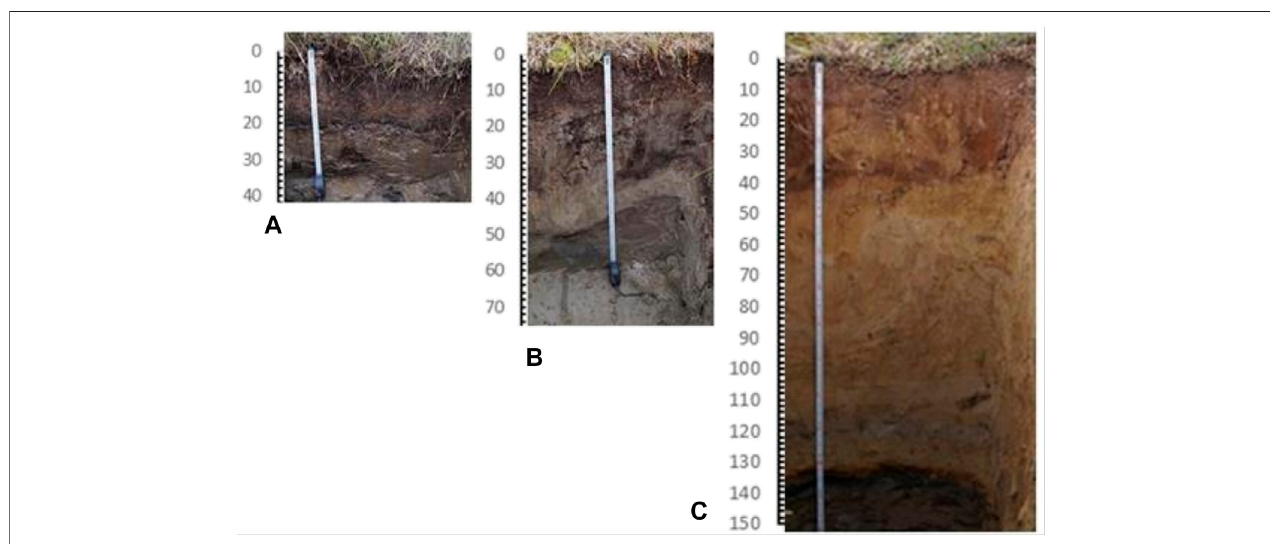
FIGURE 11 | Field campaign August 2017, soil pro fi les showing the depth of active layer 40 – 150 cm of the test site. (A) Histic Crysol with permafrost occurring at 40 cm consists of horizons: of decomposed organic matter and peat; and mineral gray to bluish soil with light loam texture, sand. (B) Histic Crysol with permafrost occurring at 70 cm consists of horizons: soil consist of peat; the mineral heterogeneous in color, gray with dark spots and light loam texture; unconsolidated Earth material with gray sandy loam texture. (C) Eutric Cryosols with permafrost occurring at 150 cm depth. The soil consists of horizons: mineral dark brown loam texture with fi ne-grained sand; yellow brown to dark brown sand; light brown sand (Photos: Balykin Dima).